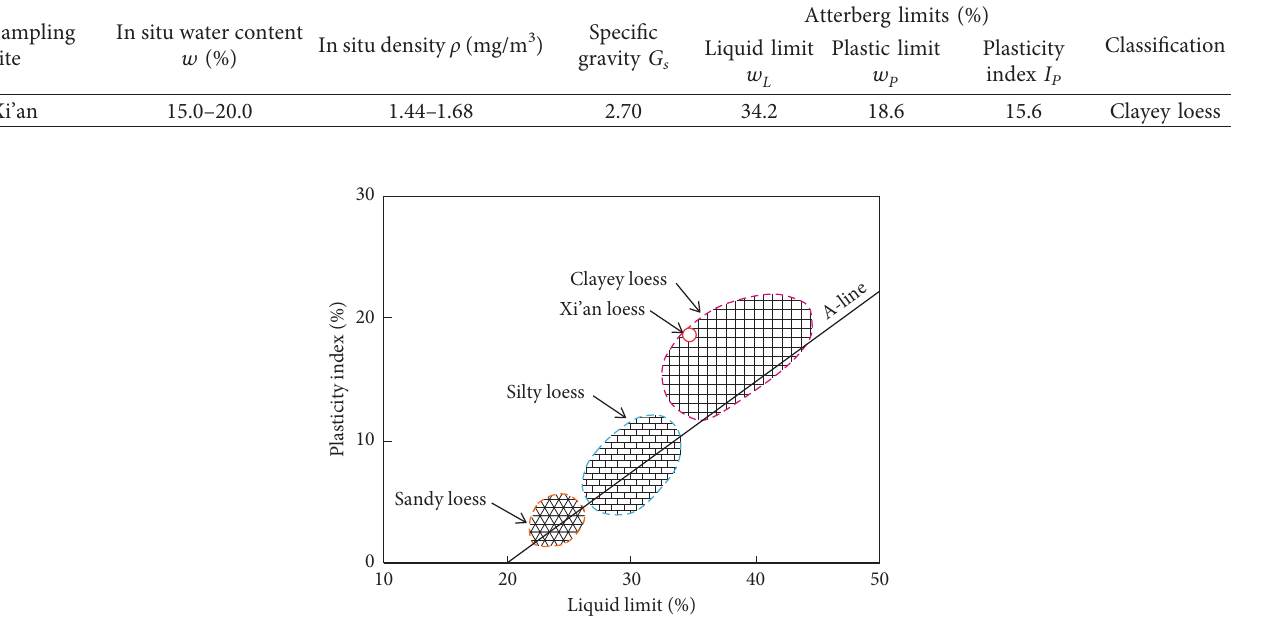
Figure 1: Plasticity chart showing the classification of the studied loess soil. Table 2: Mineralogical composition of the studied loess soil.